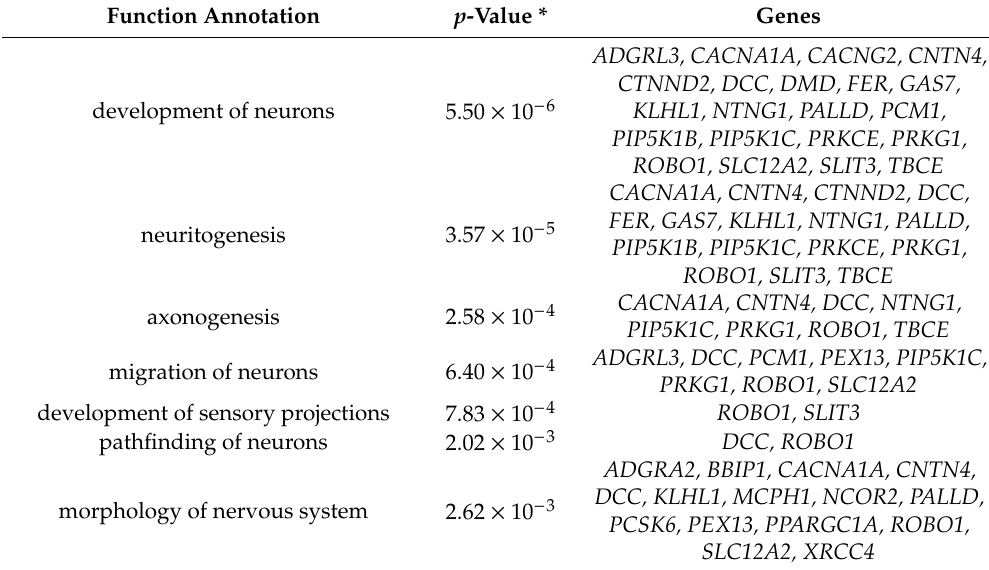
Table 13. Neurological functions of SNP-associated genes from dA.DZ vs. dNA.DZ case-control association